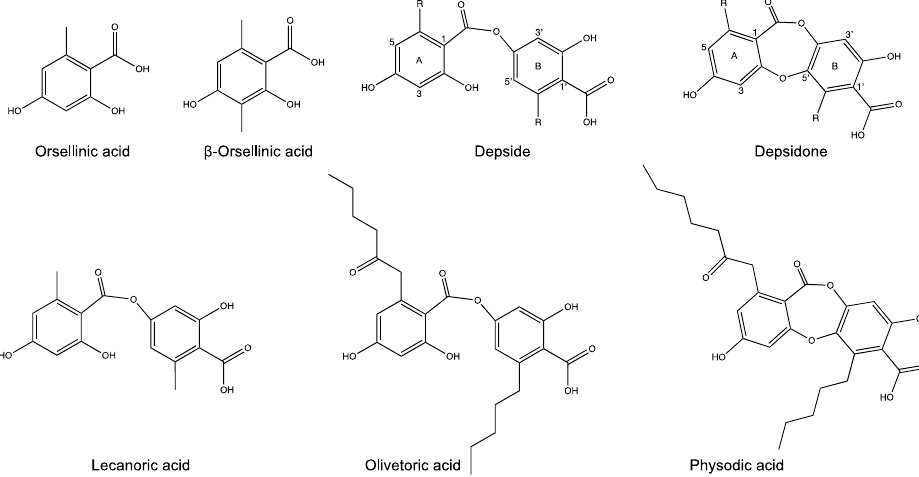
Figure 1. Chemical structures and nomenclature. Top row: monocyclic precursors and generic structures of depsides and depsidones; letters and numbers apply to all depsides and depsidones. Bottom row: the main compounds discussed here.